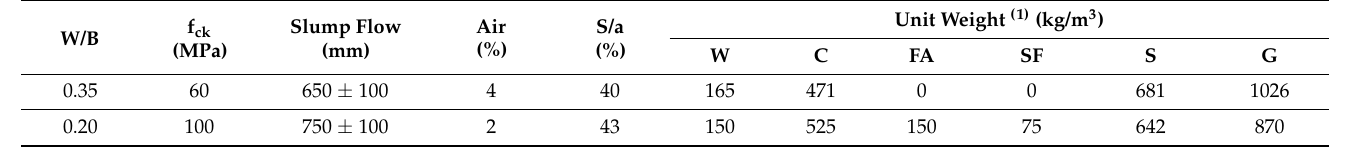
Table 2. Mix proportion of concrete used in this study. Table 1. Experimental plan for this study.